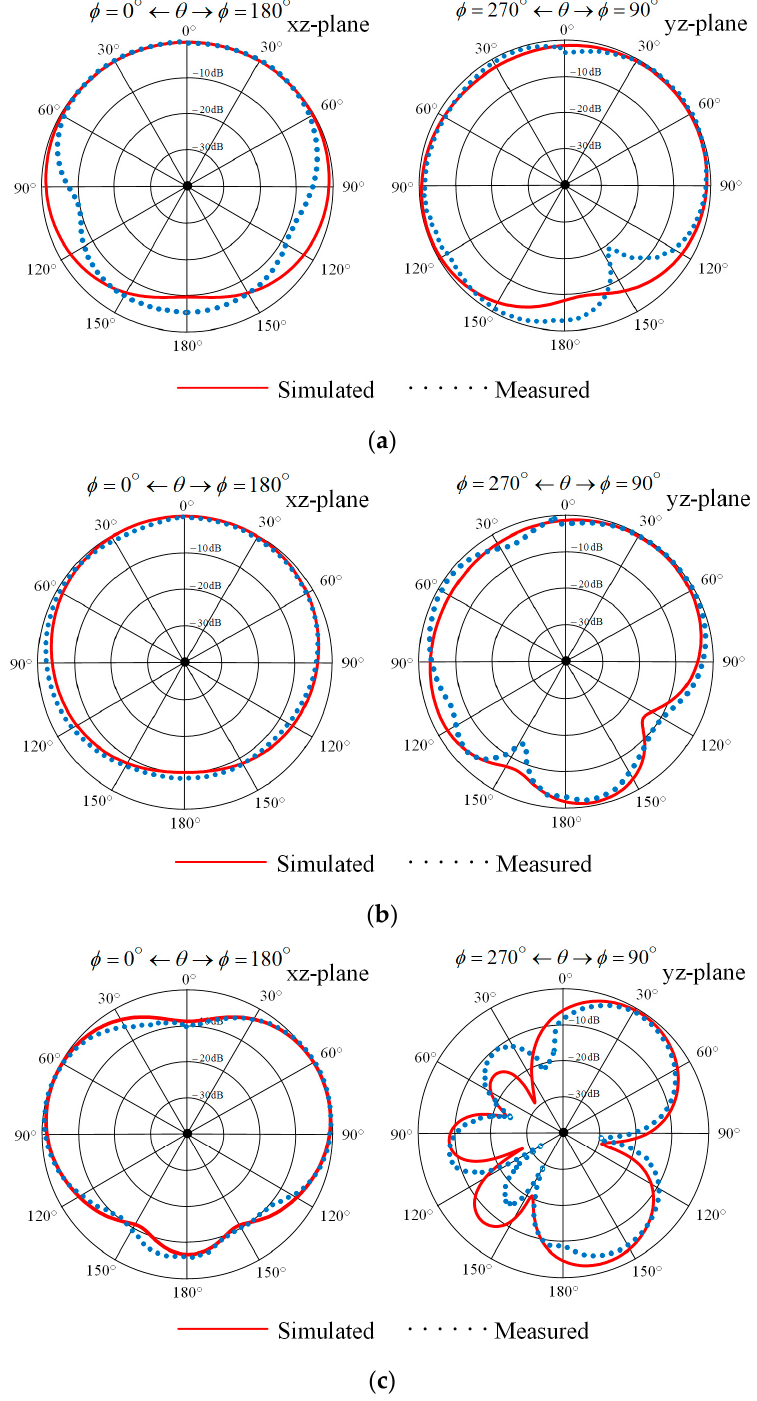
Figure 5. The simulated and measured radiation patterns of the proposed antenna in the xz and yz planes at: ( a ) 0.4 GHz; ( b ) 0.9 GHz; ( c ) 1.5